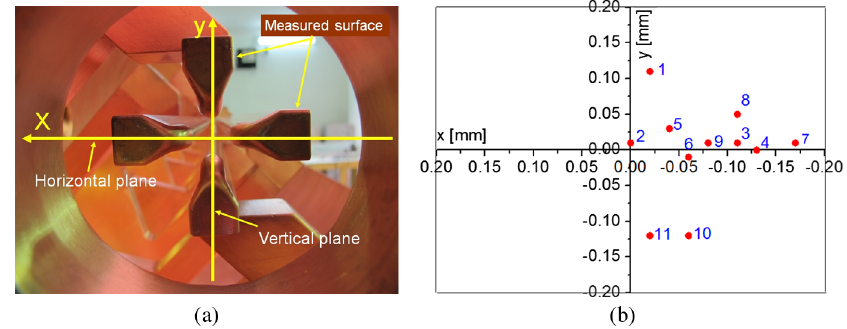
FIG. 17. The measured surfaces and the deviation